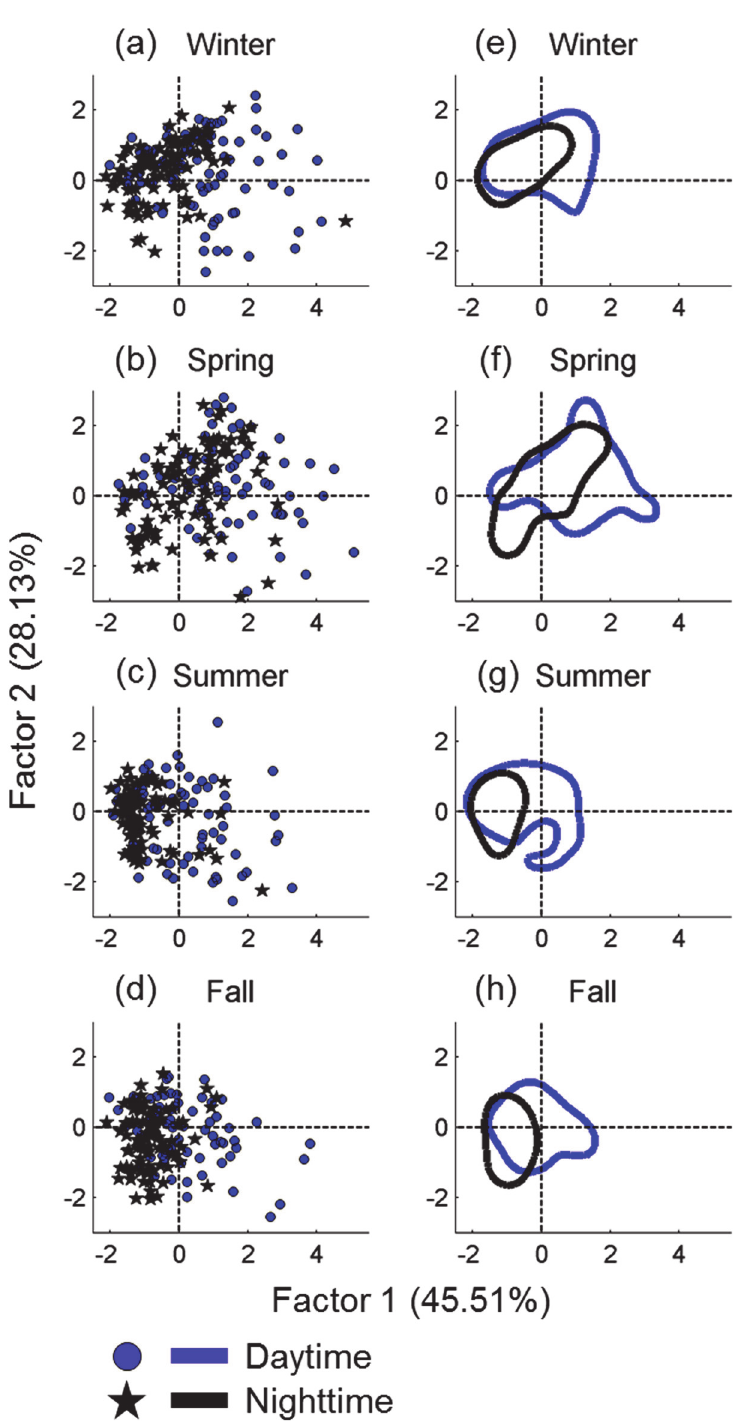
Fig 6. Seasonal and diurnal variation of whistle usage summarized based on the two component factors. Each data point represents one of two diurnal periods in each season after principle component analysis (a – d). The circled areas represent the 50% central areas of the two diurnal periods in each season estimated using the kernel density method (e –